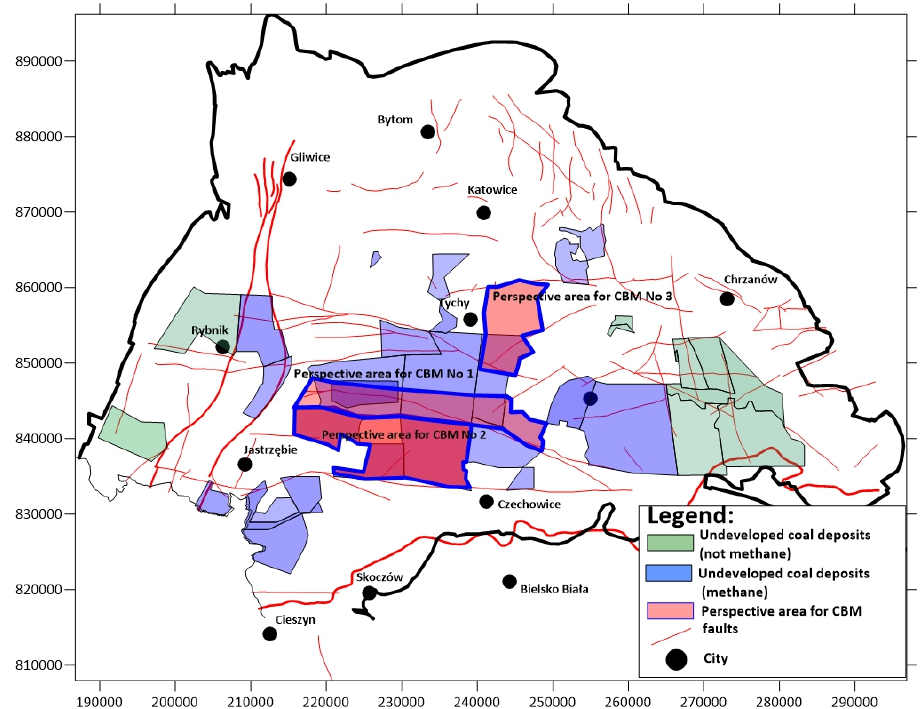
Figure 5. Prospective regions in terms of methane production using directional drilling from the surface set against the undeveloped areas of the Upper Silesian Coal Basin.